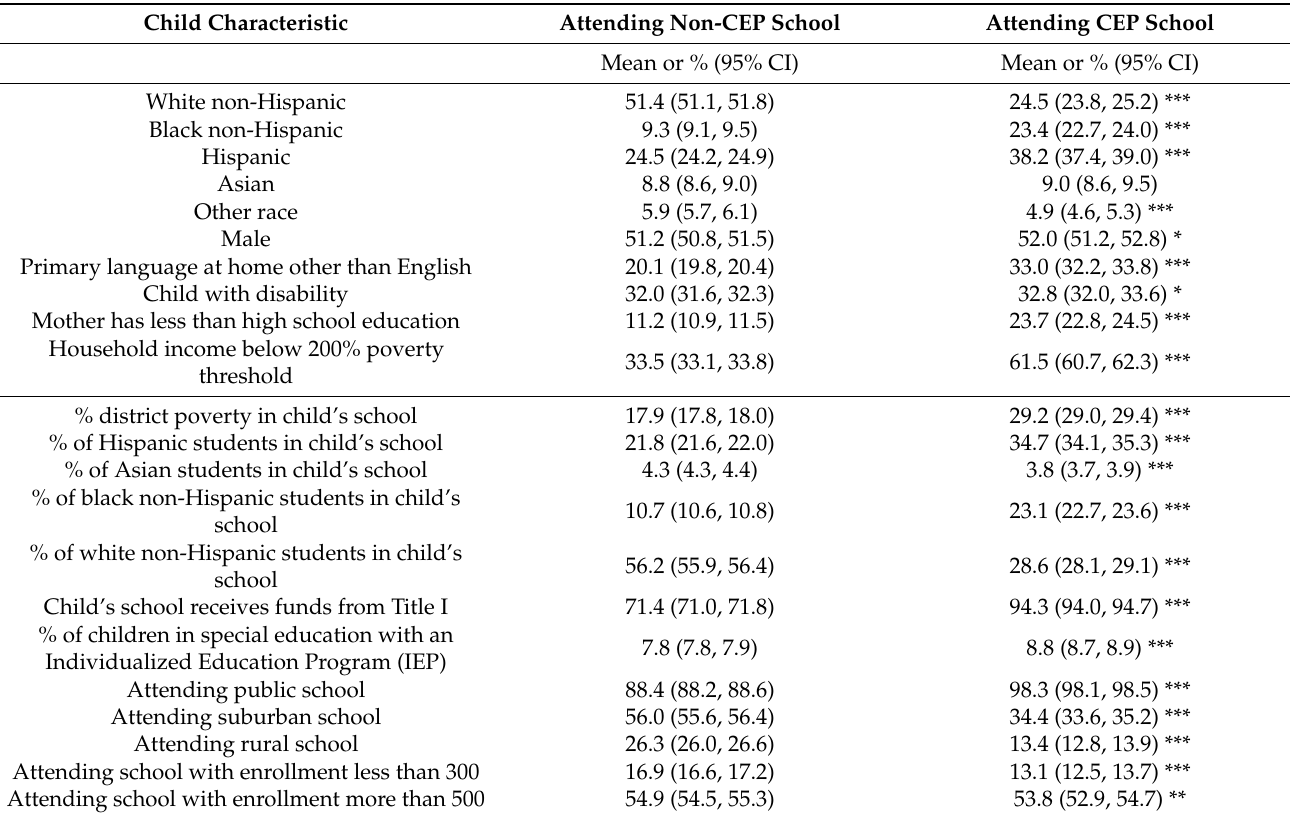
Table 2. Child Characteristics by CEP Participation Status from the Early Childhood Longitudinal Study, Kindergarten Class of 2010–2011